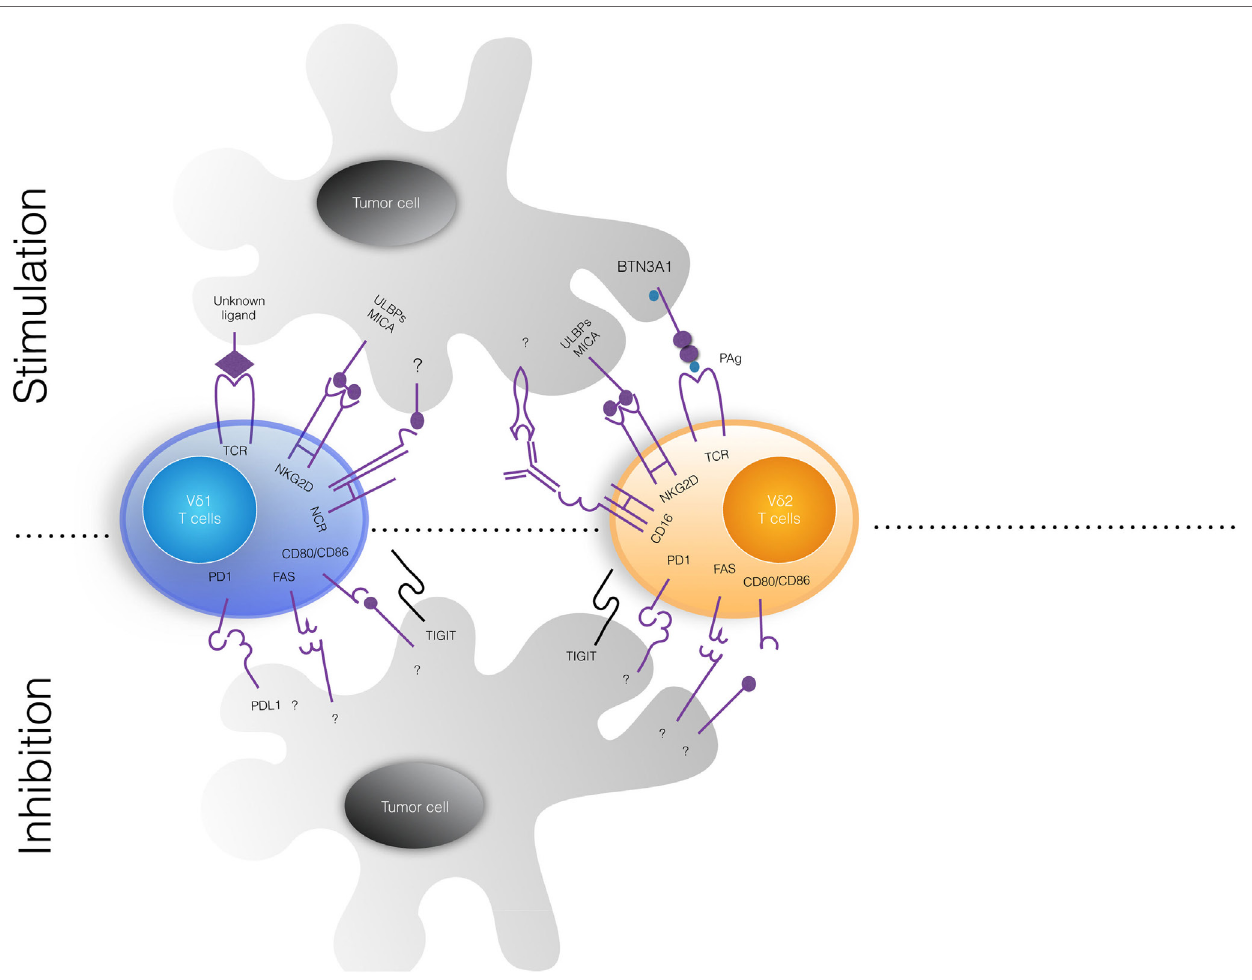
FiGURe 1 | Tumor cell ligands recognized by human γδ T cells. The upper and lower panels show stimulatory and inhibitor signals delivered by tumor cells to V δ 1 (left) and V δ 2 (right) γδ T cell subsets. V γ 9V δ 2 T cells recognize via their TCR non-peptidic phosphoantigens (PAgs) and BTN3A1, while V δ 1 T cell receptor (TCR) ligands are not defined yet. Both γδ T cell subsets constitutively express surface natural cytotoxicity cell receptors (NCRs) that bind MICA/MICB and ULBPs, frequently expressed on tumor cells. Upon activation, V γ 9v δ 2 T cells express fragment crystallizable receptor for IgG (Fc γ RIII; also known as CD16) that can bind therapeutic antibodies and mediate antibody-dependent cell-mediated cytotoxicity phenomena. Inhibitor signals delivered by tumor cells have not been well characterized. MICA/B, MHC class I-related chain A/B; ULBP, UL16-binding protein; BTN3A1, butyrophilin